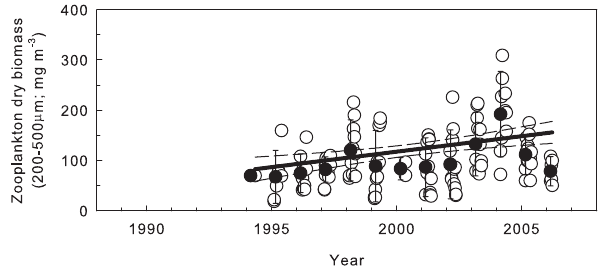
Fig. 5. Time-series of daytime zooplankton biomass (mg dry weightm − 3 ) in the 200–500µm size class at the BATS site. Solid line is the least squares Model 1 regression, and the dashed lines are the 95% confidence